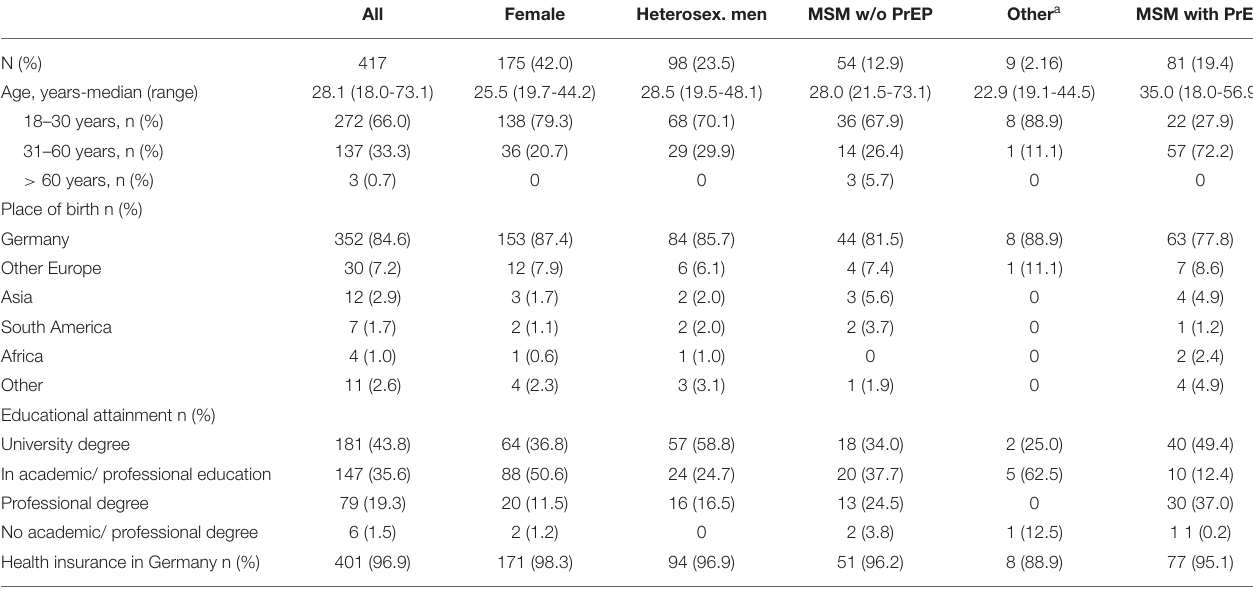
TABLE 1 | Baseline characteristics of clients presenting at the Center for Sexual Health Freiburg, Germany, between 1 May 2020 and 28 February 2021. All